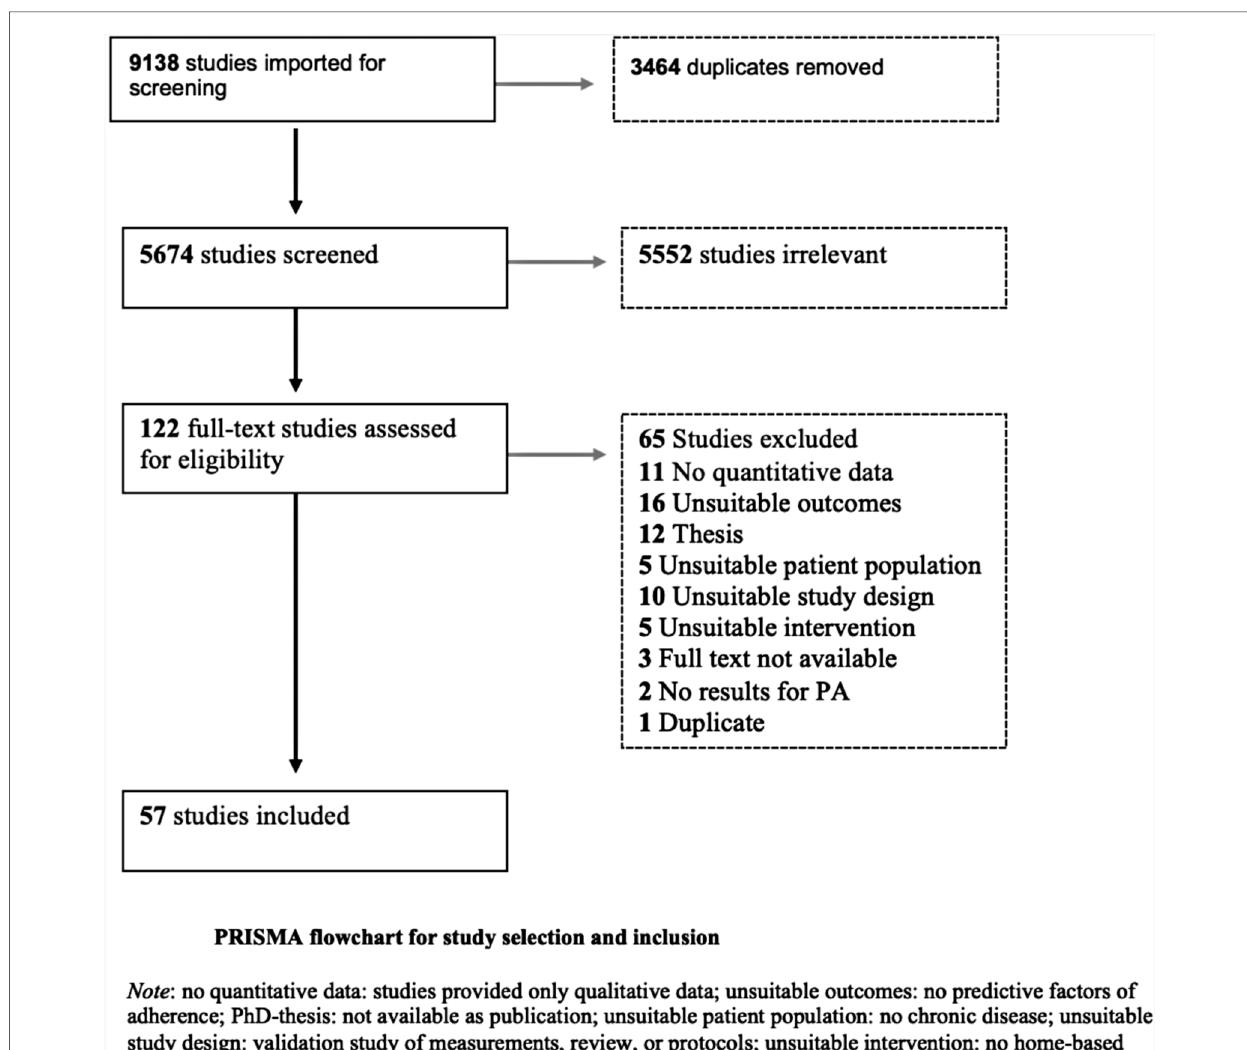
FIGURE 1 PRISMA fl owchart for study selection and